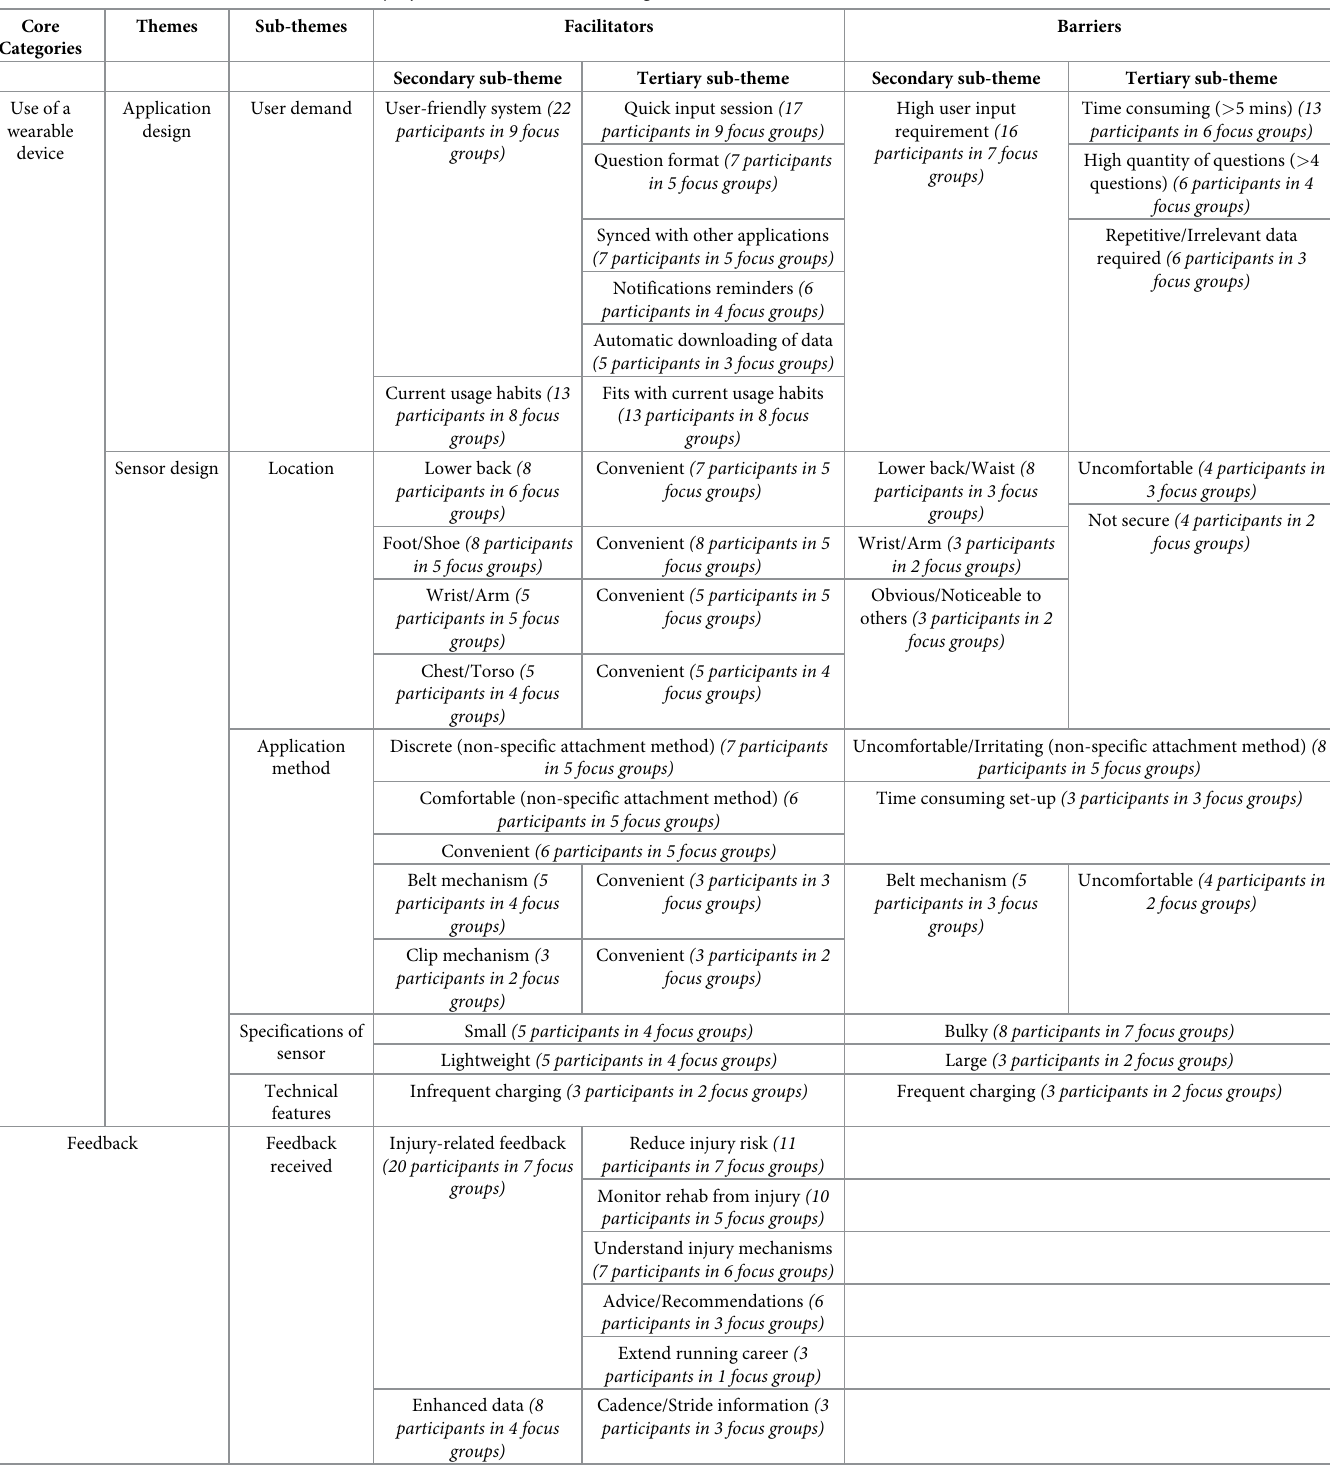
Table 3. Facilitators and barriers to the use of injury-focused wearable